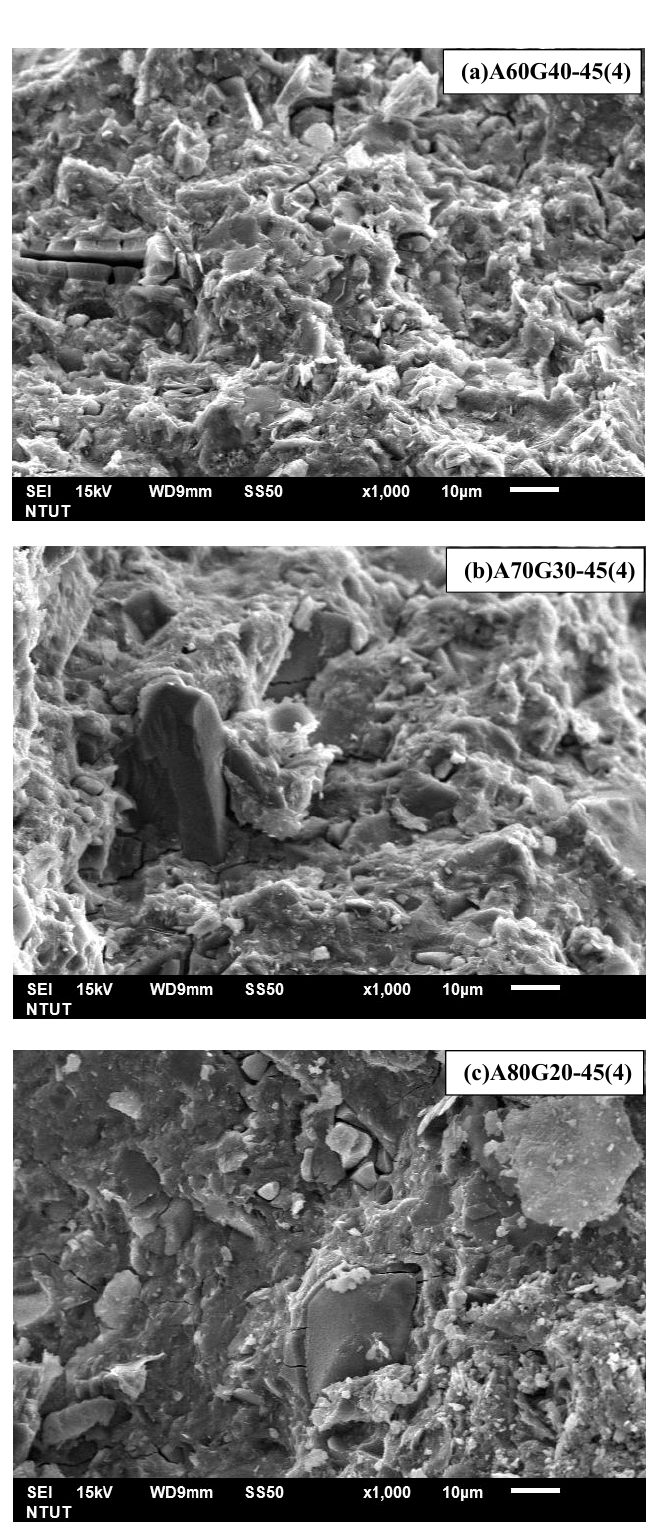
Figure 7. Influence of AS/GGBFS ratio on the compressive strength of AG geopolymer mortar.